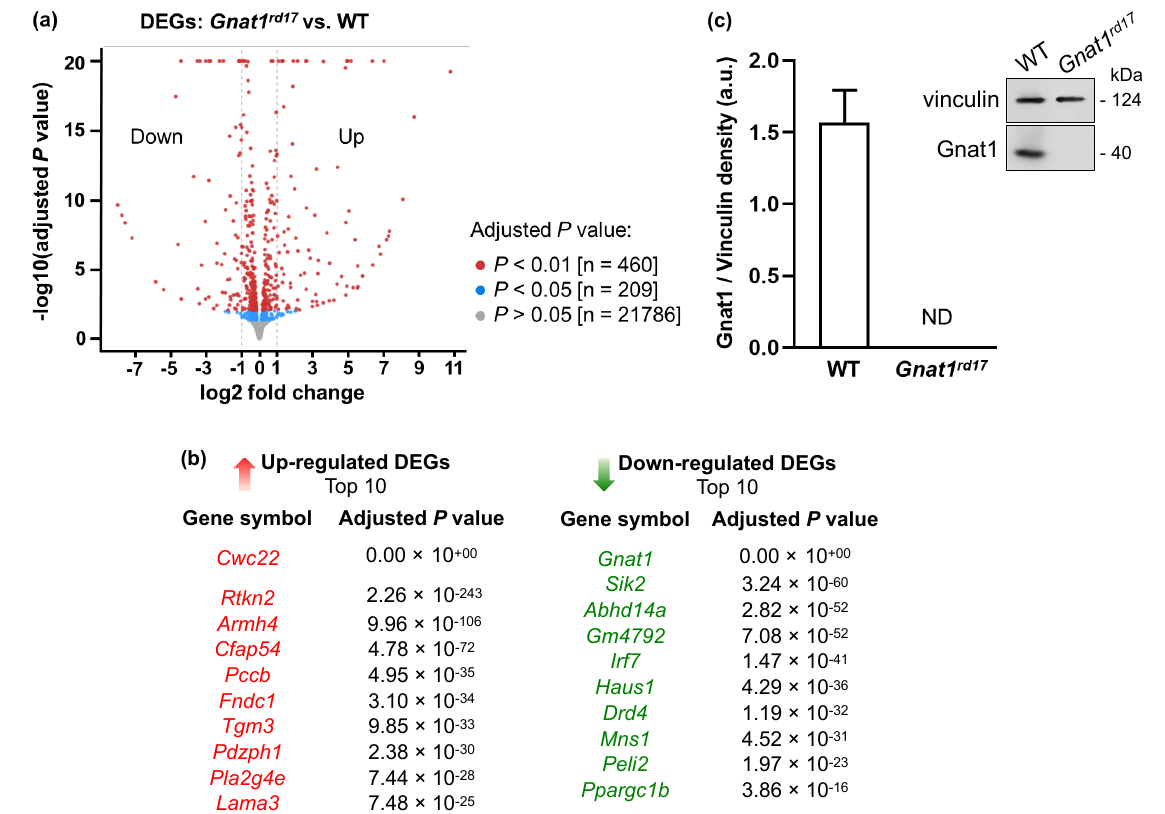
Figure 3. Retinal transcriptomic remodeling in Gnat1 rd17 mice. ( a ) Volcano plot showing DEGs in the neuroretina of Gnat1 rd17 mice compared to WT mice. The vertical dot lines define upregulated (log2 fold change > 1) and downregulated (log2 fold change < − 1) DEGs. The red and blue dots indicate all genes at adjusted p < 0.01 and p < 0.05, respectively. The grey dots represent all genes with an adjusted p > 0.05. ( b ) The top 10 most significantly upregulated and downregulated protein-coding DEGs, as determined by adjusted p -value. ( c ) Representative Western blot images and relative protein expression of Gnat1 assessed by densitometry. Vinculin was used as a protein-loading control. The data represent the mean ± SEM of 5 neuroretinas of five normal WT and five Gnat1 rd17 mice at the age of 10 weeks. The data shown are representative of three independent experiments.